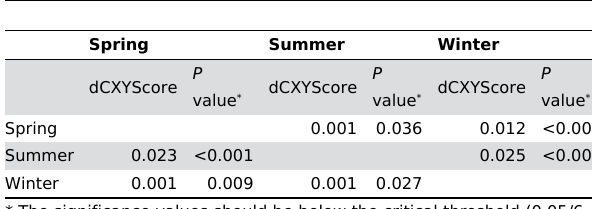
Table 4. LIBSHUFF analysis of the community structures of spring samples, summer samples and winter samples at an OTU definition level of 97%.